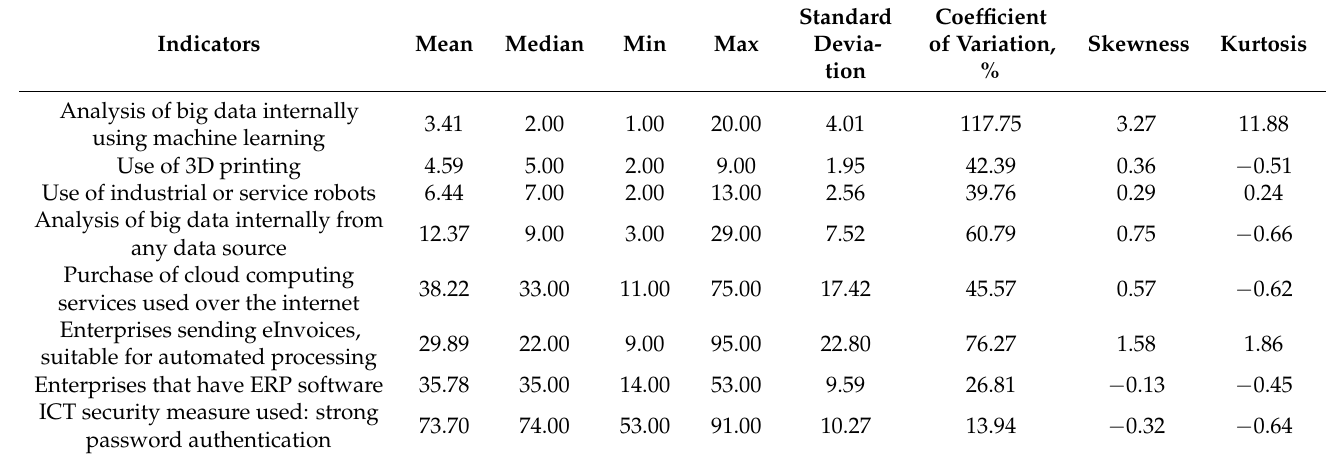
Table 3. Basic descriptive statistics of the indicators adopted for the study.